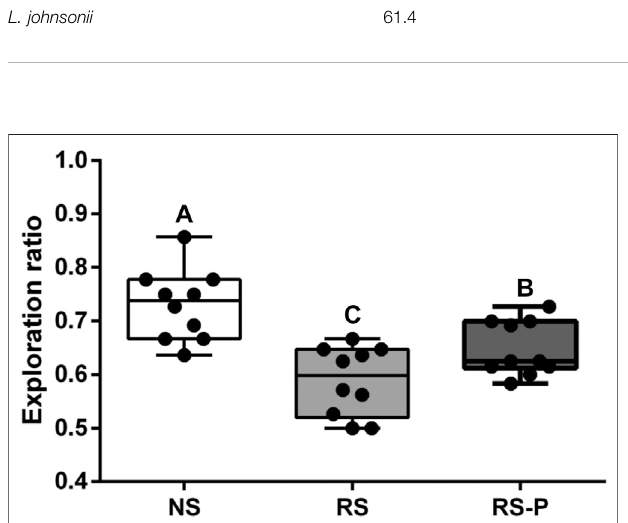
FIGURE 2 | Effects of L. johnsonii BS15 on exploration ratio by novel object test. Data are presented with the means ± standard deviation ( n (cid:2) 10). Bars with different letters are signi fi cantly different on the basis of Duncan ’ s multiple range test ( P < 0.05).